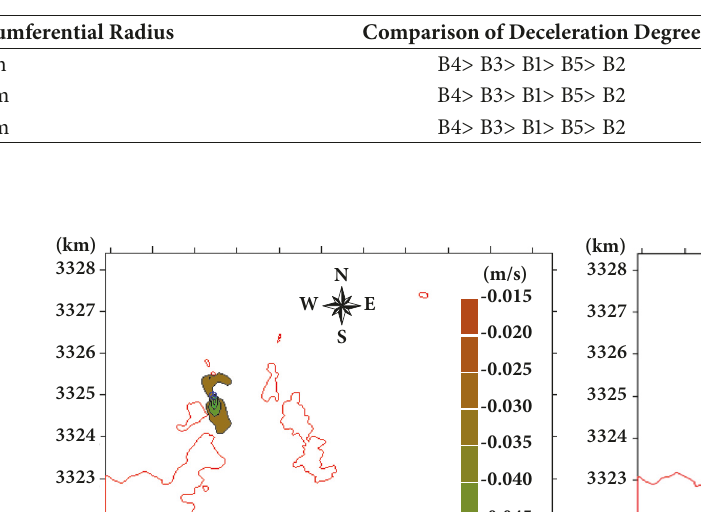
Table 4: Comparison of deceleration and growth degree.